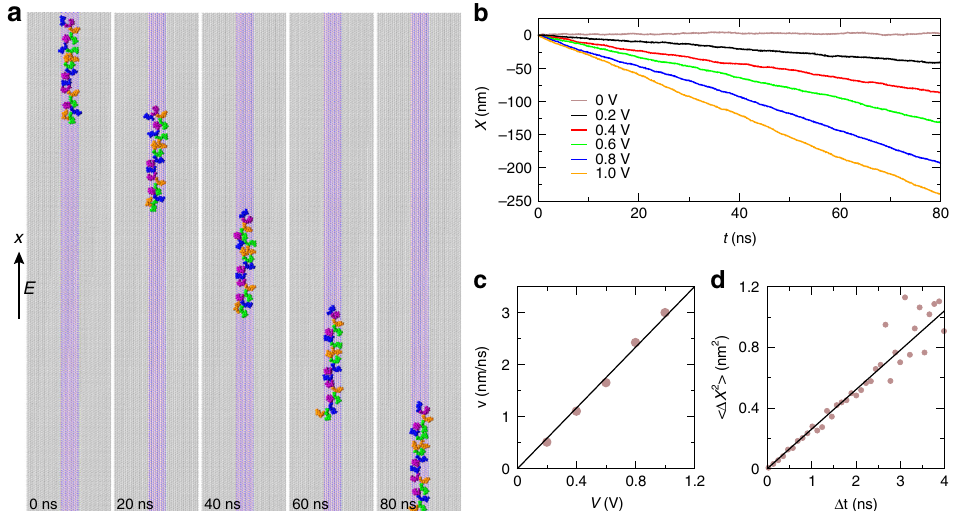
Fig. 3 Electrophoretic transport of ssDNA on the graphene/h-BN/graphene heterostructure. a Illustration of electrically driven motion of ssDNA at different times ( V = 0.2 V). The electric fi eld is applied along the h-BN stripe. b Time-dependent displacements of ssDNA in various external biasing voltages. c Mean velocities of ssDNA at various applied biasing voltages. d Mean-square-displacements of ssDNA at different time intervals, when V = 0